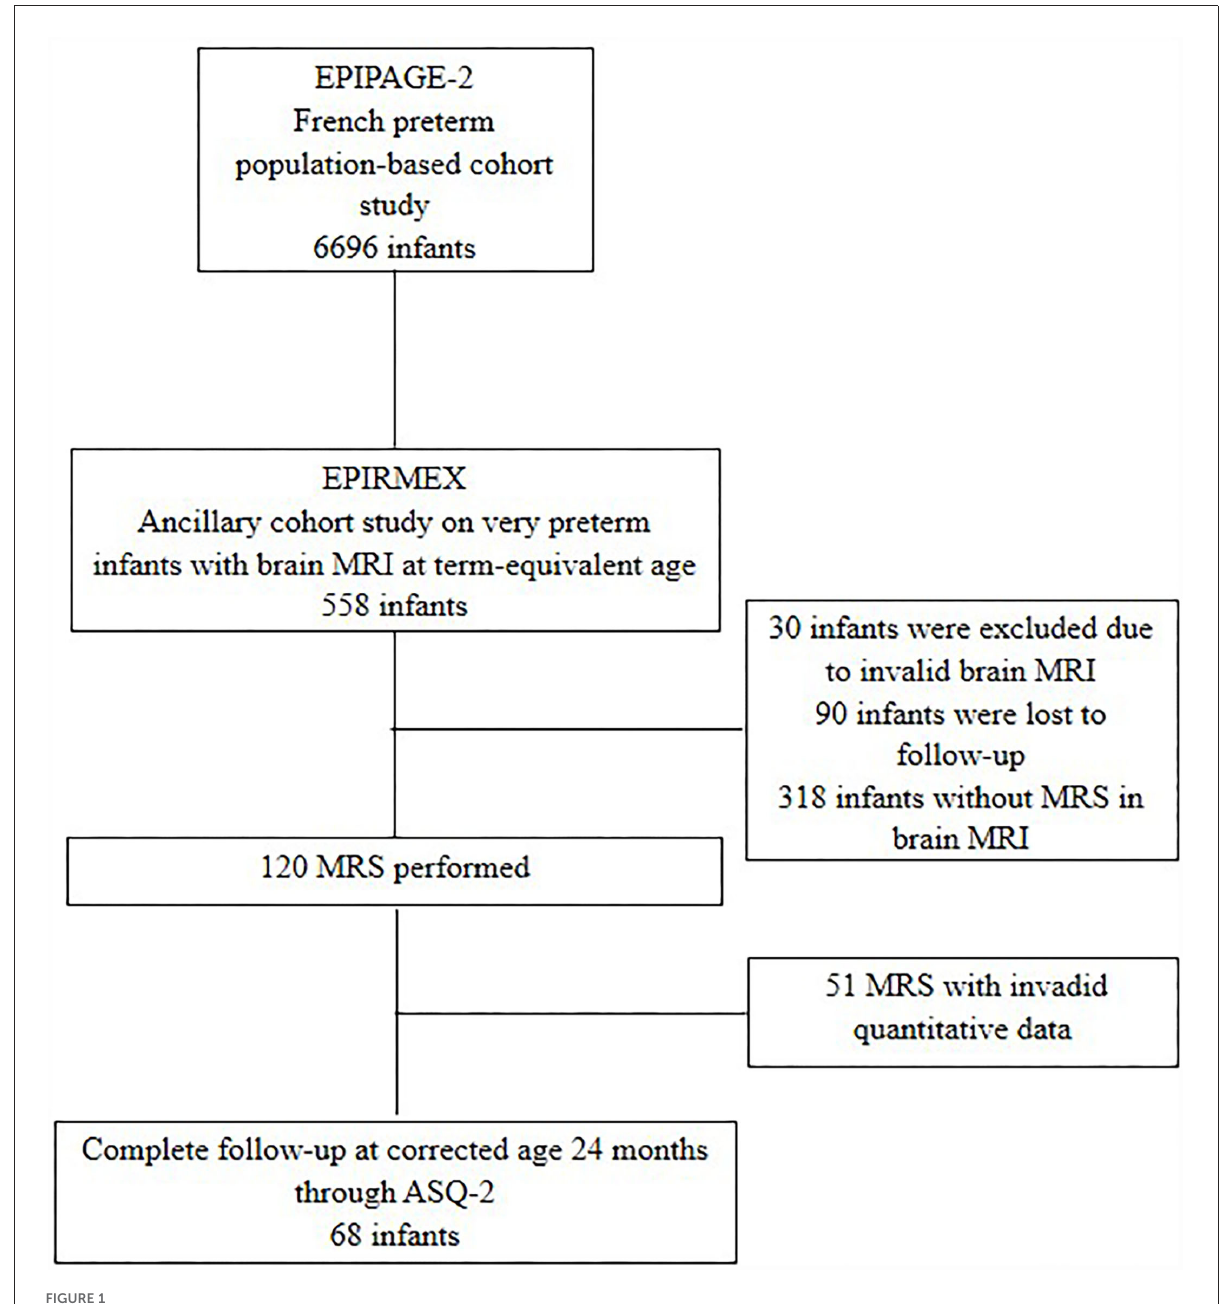
FIGURE1 Study flow-chart.